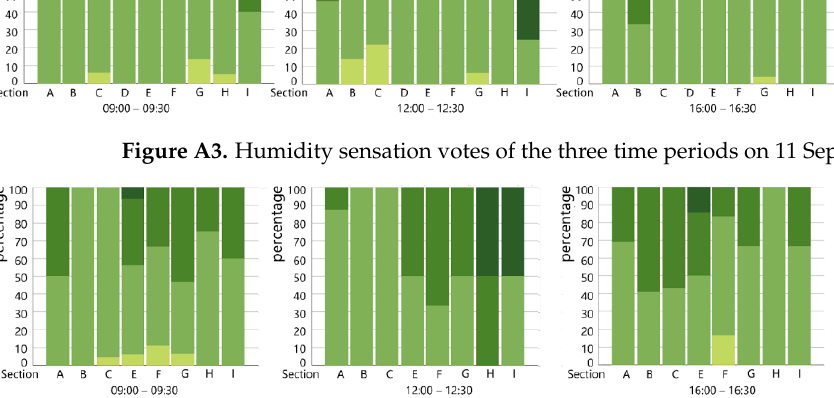
Figure A4. Humidity sensation votes of the three time periods on 12 September.